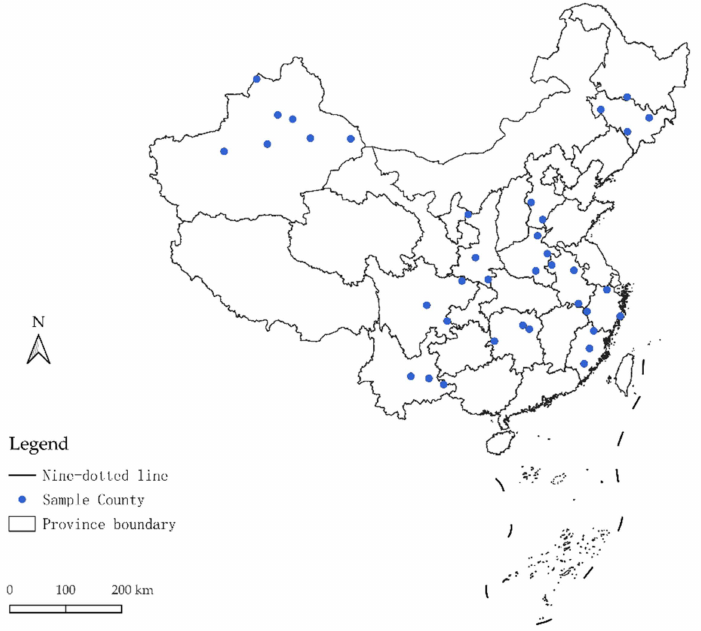
Figure 2. The geographical location of the study